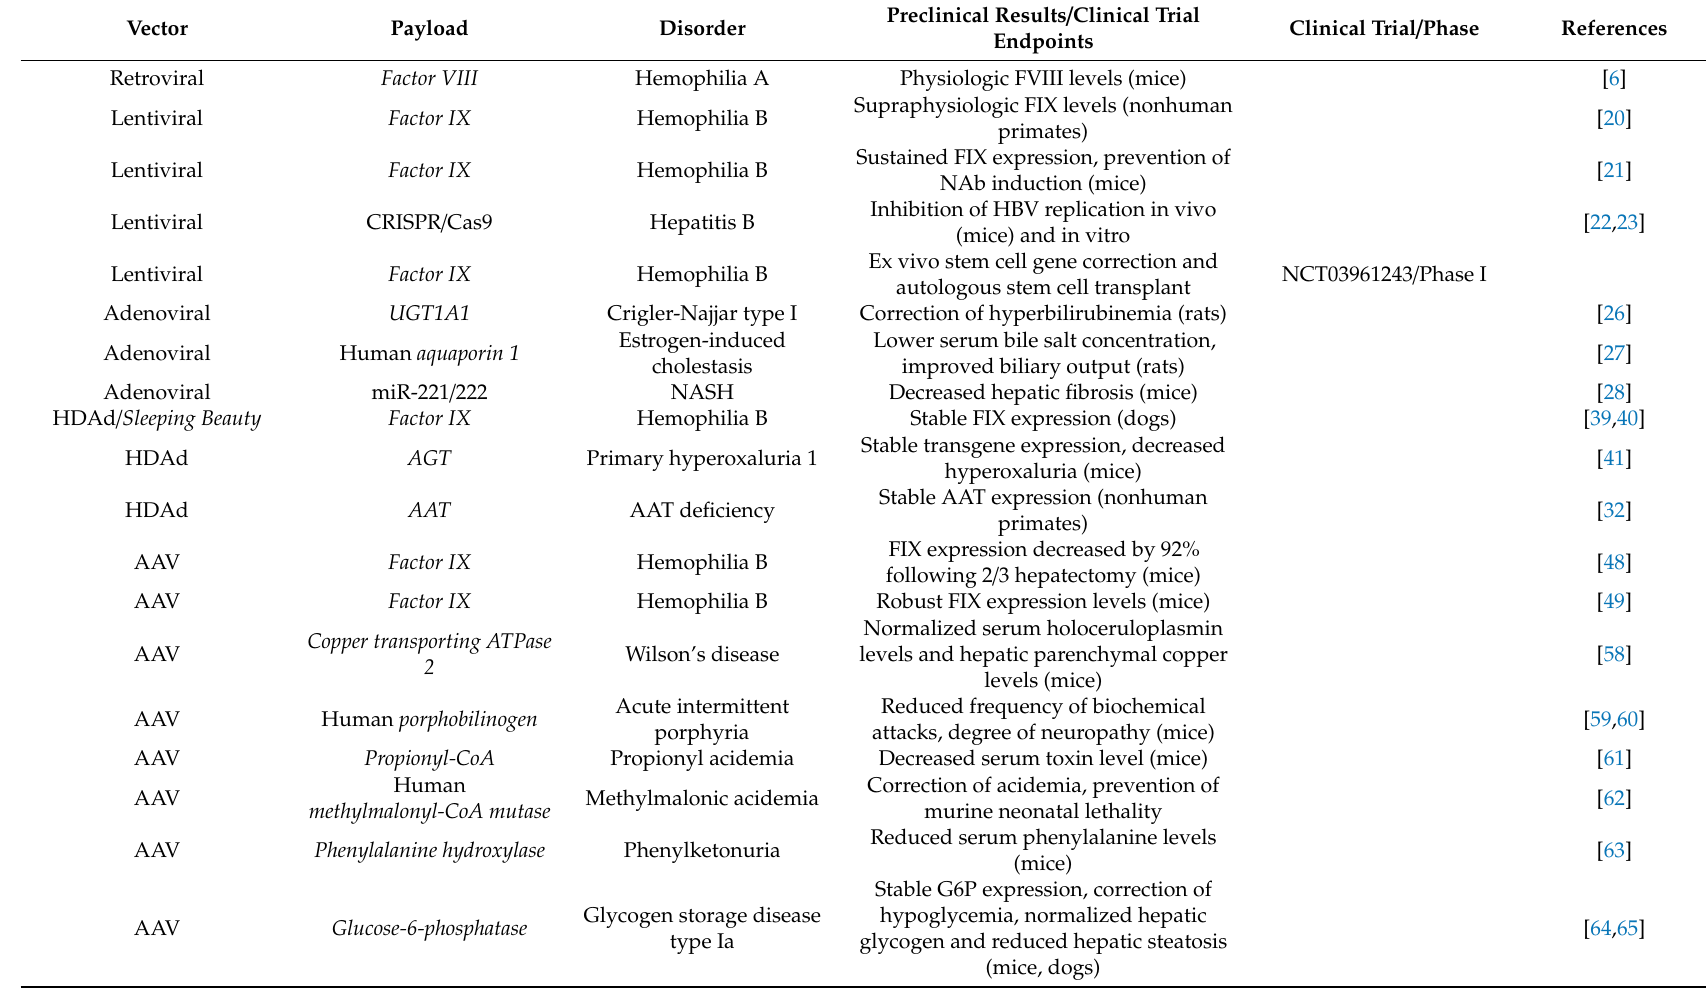
Table 1. Summary of preclinical and clinical trials of liver targeted gene